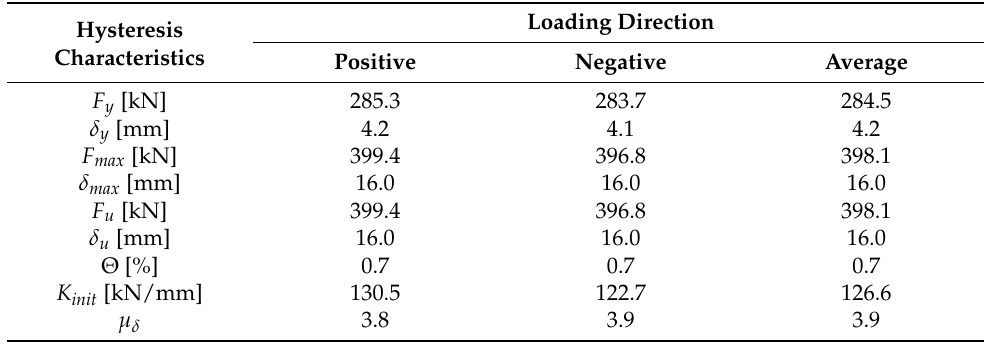
Figure 25. Plastic damage on the lower joint of the tested PCSP-ISF model. The corresponding out-of-plane displacement measurements also confirmed the ab- sence of instability phenomena due to the PCSP-ISF’s small thickness-to-width ratio. The obtained hysteresis characteristics, including yield strength ( F y ), yield displacement ( δ y ), maximum strength ( F max ), maximum displacement ( δ max ), ultimate strength ( F u ), ultimate displacement ( δ u ), maximum drift ratio ( θ ), initial stiffness ( K init ), and ductility factor ( µ δ ), are summarised in Table 2. The initial stiffness was defined as the slope of the skeleton curve at the first loading cycle. The yield displacement was obtained through the bilin- earisation of the experimental load displacement curve, as described in Annex B of EN 1998-1 [36]. The ultimate state is defined as the point of the skeleton curve corresponding to deformation capacity beyond the maximum strength [37,38]. Herein, the experiment was terminated without capturing the response at the post-peak range, and thus, the ultimate state was considered the point corresponding to maximum strength and displacement. Table 2. Obtained hysteresis characteristics of the tested PCSP-ISF